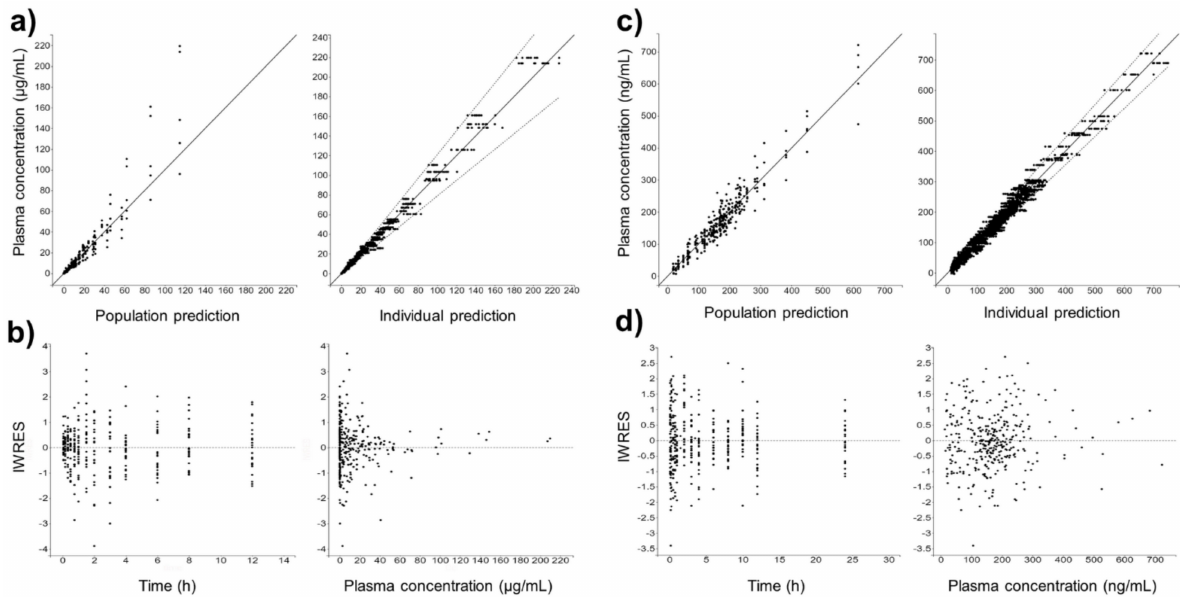
Figure 5. Goodness-of-fit for final popPK models. ( a ) Observation vs. prediction plots using population and individual parameters (including 10 predictions for each observation) for intravenous rutin; solid and dashed lines represent the linear regression fit and the 90% prediction interval, respectively. ( b ) Scatter plots of individual weighted residuals (IWRES) with respect to time and predicted plasma concentration for intravenous rutin. ( c ) Identical to ( a ) for quercetin from oral rutin. ( d ) Identical to ( b ) for quercetin from oral rutin. Quercetin represents the conjugates quercetin-3- O -glucuronide and quercetin-3- O -sulfate.